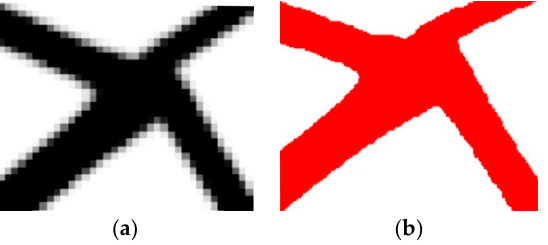
Figure 1. Mesh refining as the remedy for non-smooth boundaries: ( a ) example of a coarse mesh; ( b ) example of a fine mesh.